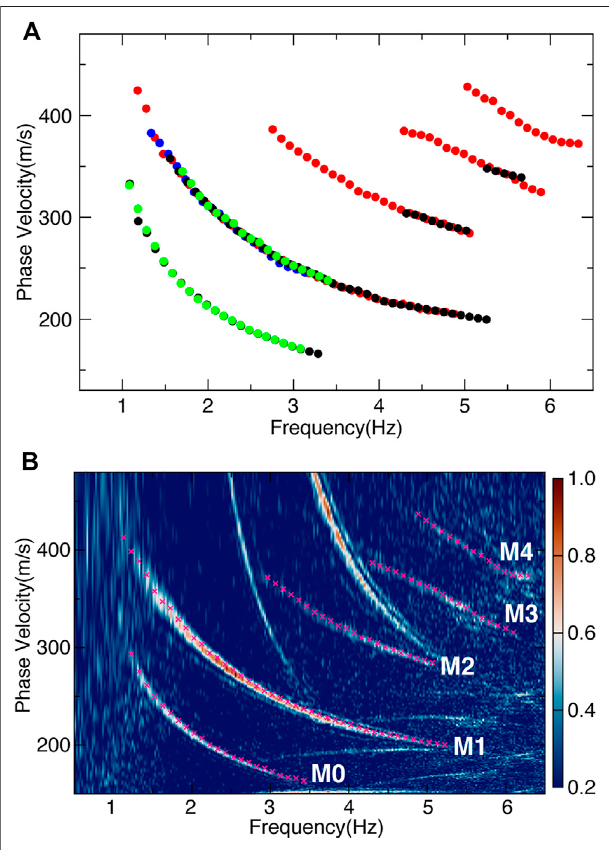
FIGURE 5 | Dispersion curves selected from the 4C VSs shown in Figure 3 (A) and the stacked VS (B) . The red, blue, black, and green dots in (A) denote the BH1, BH2, BHZ, and HYD components, respectively. The M0 – M4 in (B) denote the dispersive mode